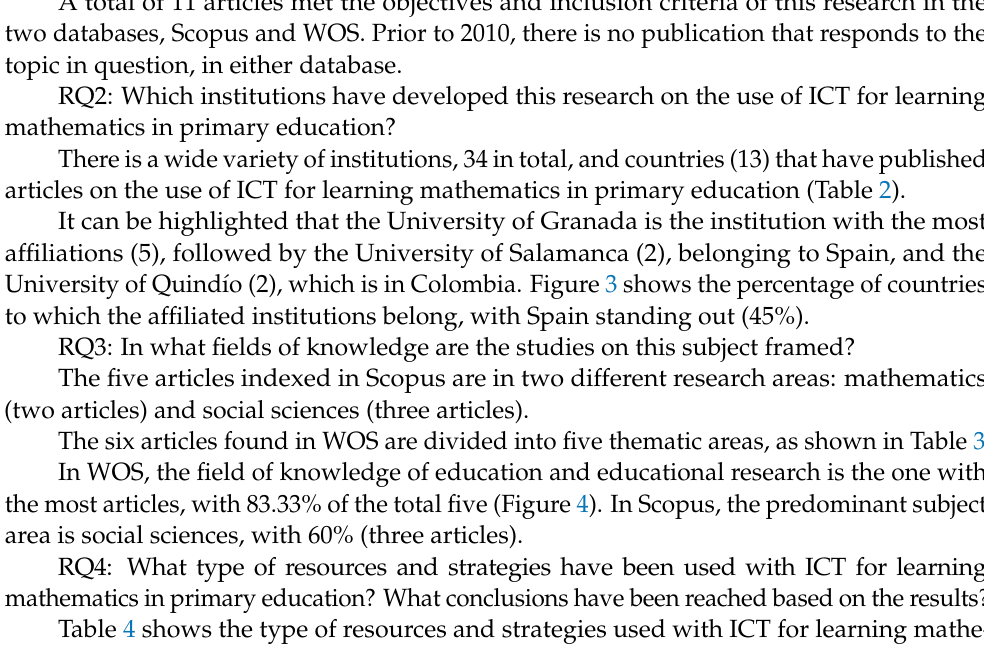
Table 2. Institutions with which the authors of the articles listed are affiliated.